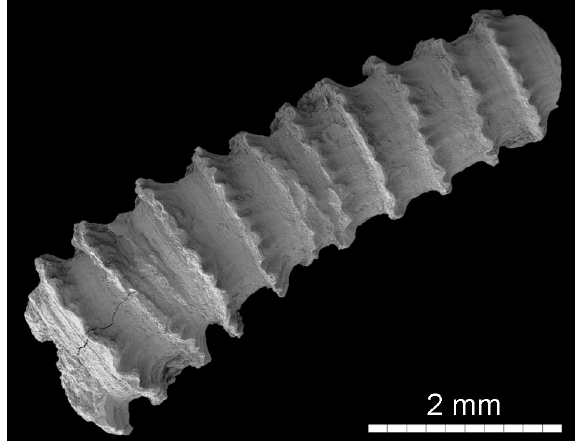
Fig. 2. Conchicolites crispisulcans sp. nov. (holotype TUG 1675-1) from the Mulde Brick-clay Member of the Halla Formation, Homerian of Gotland. SEM